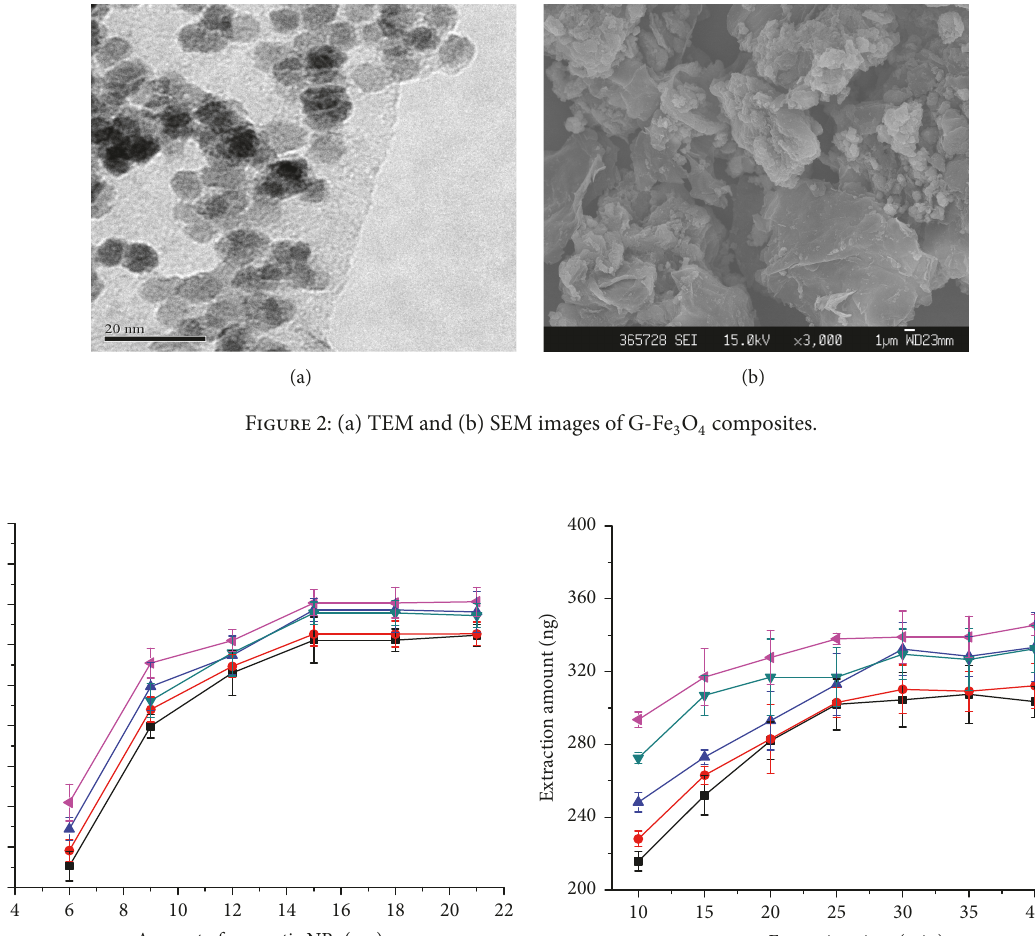
parameters, including the amount of G-Fe 3 O 4 , extraction solvent, extraction time, and desorption conditions, were explored in order to achieve the best extraction efficiency.